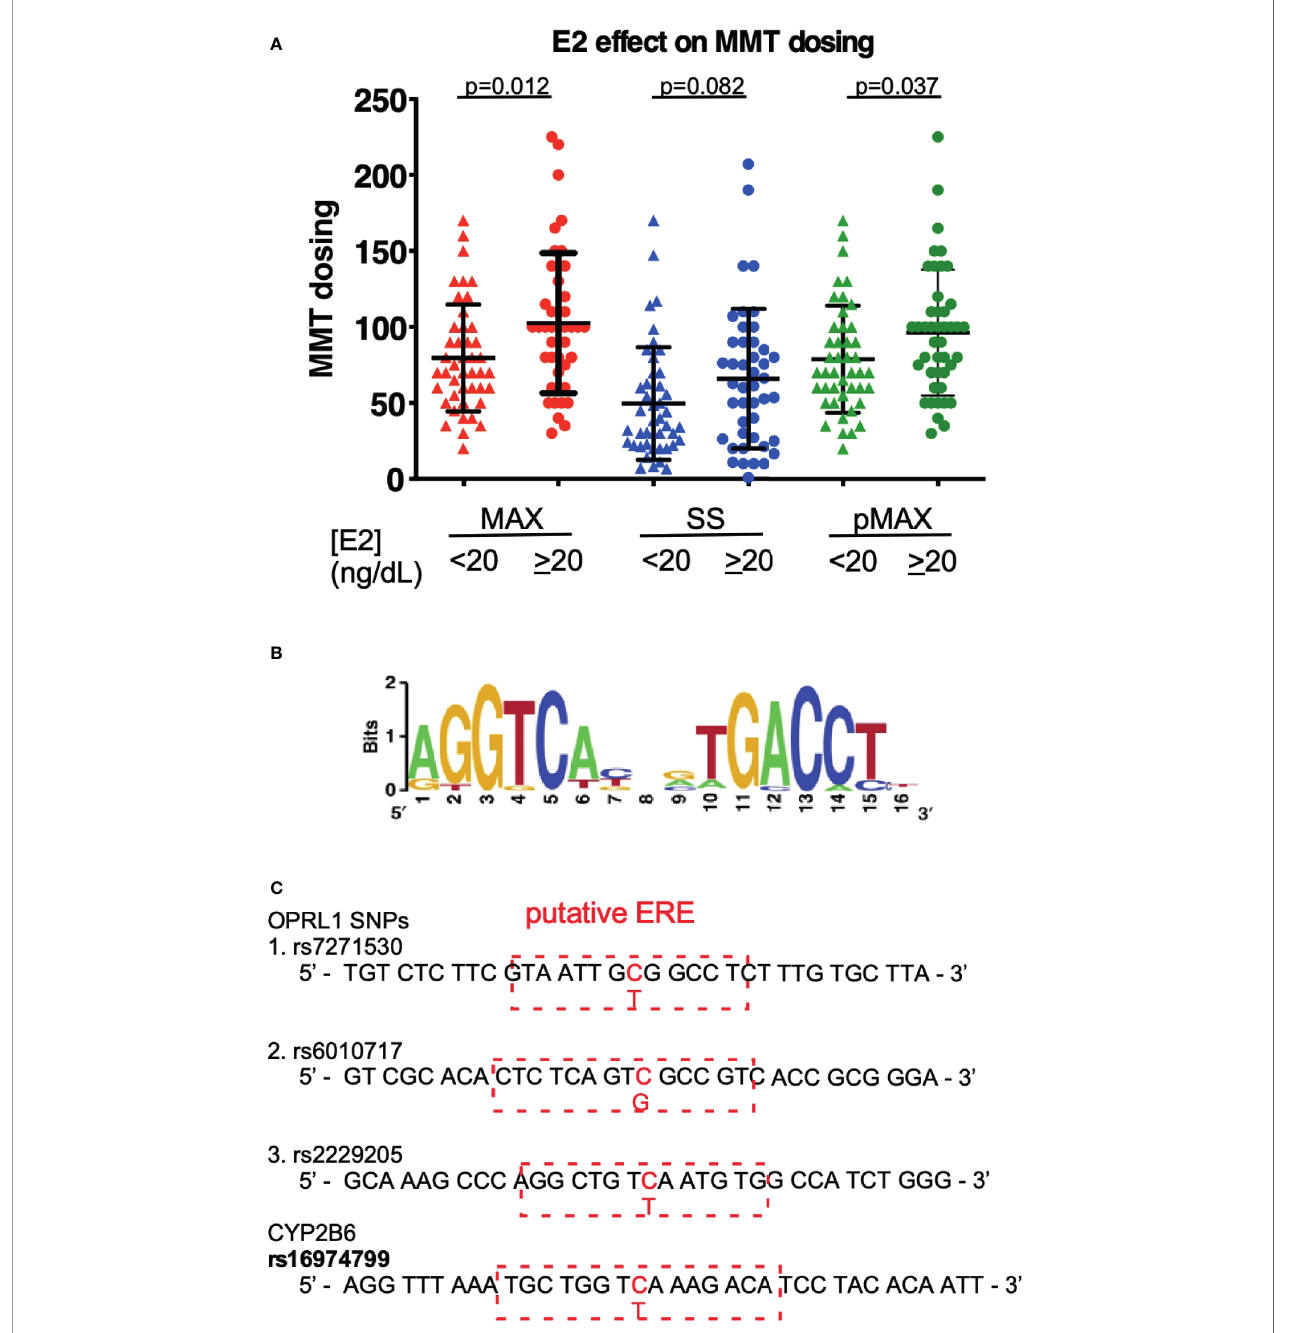
FIGURE 1 | E2 effects on MMT dosing. (A) The MMT dosing in patients with low (<20 ng/dL) or high ( ≥ 20 ng/dL) estradiol (E2) levels. MAX (red-colored dots) indicates the maximal dosing of methadone during the MMT regimen; SS (blue-colored dots) indicates the steady-state dosing of methadone during the MMT regimen; and pMAX (green-colored dots) indicates the previous MAX of patients receiving a previous term of MMT. (B) The classical ERE sequences and scoring standard for predicting a potential SNP-ERE. (C) The locations of the four SNPs on the putative ERE. The OPRL1 SNPs (rs7271530, rs6010717, and rs2229205) and CYP2B6 SNP (rs1694799) sequences are shown, and red-dashed rectangles depict the putative ERE region and nearby sequences. The * indicates a signi fi cant p-value < 0.05 obtained using Student ’ s